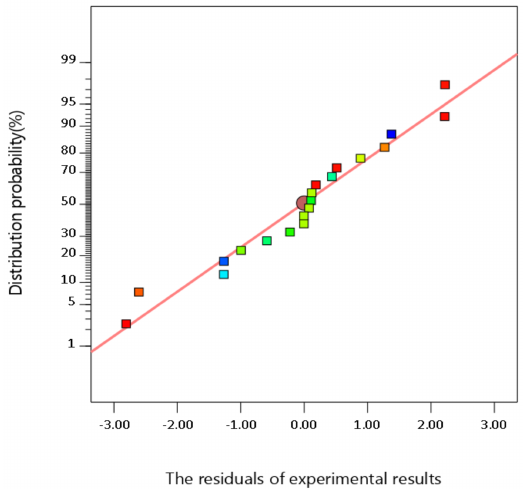
Figure 7. Normal probability distribution of residuals.